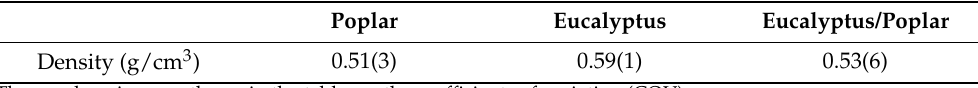
Table 1. Average density of plywood. Poplar Eucalyptus Eucalyptus/Poplar Density (g/cm 3 )